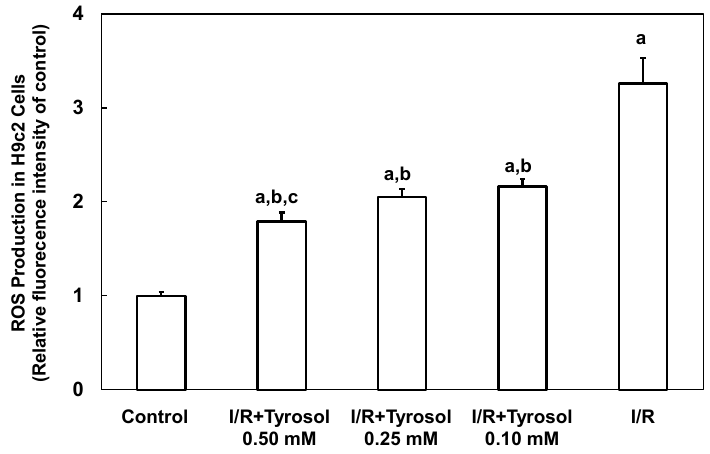
Figure 4. Effect of tyrosol on intracellular ROS production in H9c2 cardiomyocytes during I/R. Cells were incubated with tyrosol (0.10, 0.25, and 0.50 mM) before and during